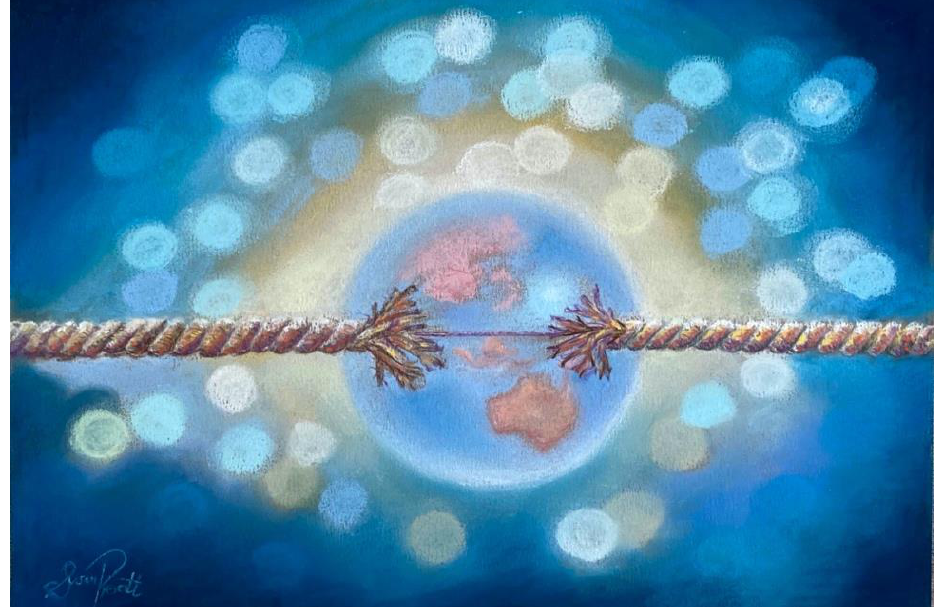
Figure 2. “Breaking points”: connections between personal and planetary health . Large-scale damage to natural systems and erosion of social environments is implicated in the unparalleled rise in mental and physical disease — through both biological and psychological pathways. As many as 75% of youth are frightened about the future because of climate and environmental concerns. (Art created by author S.L.P.).